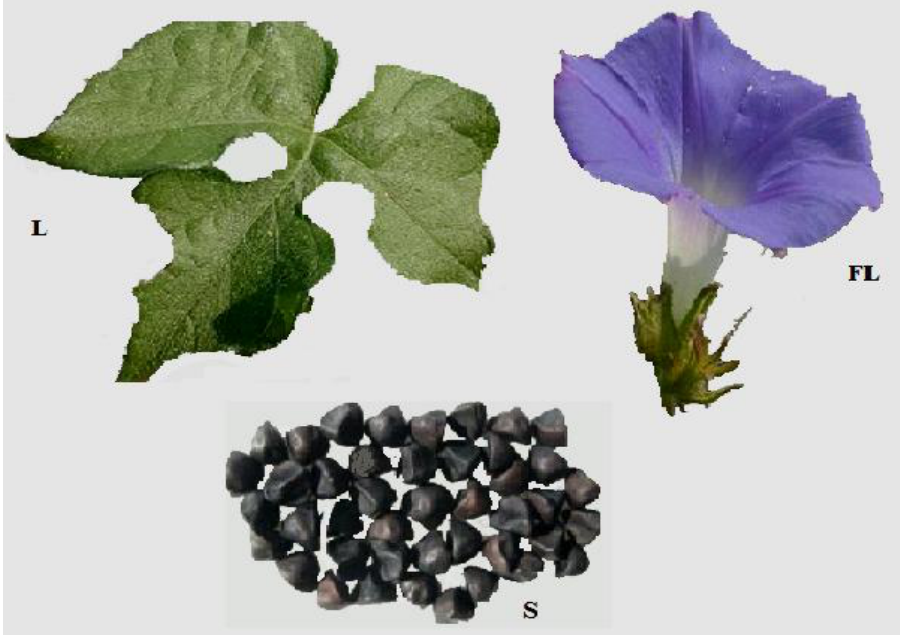
Figure 2. Ipomoea hederacea Jacq., FL, flower; L, leaf, S,